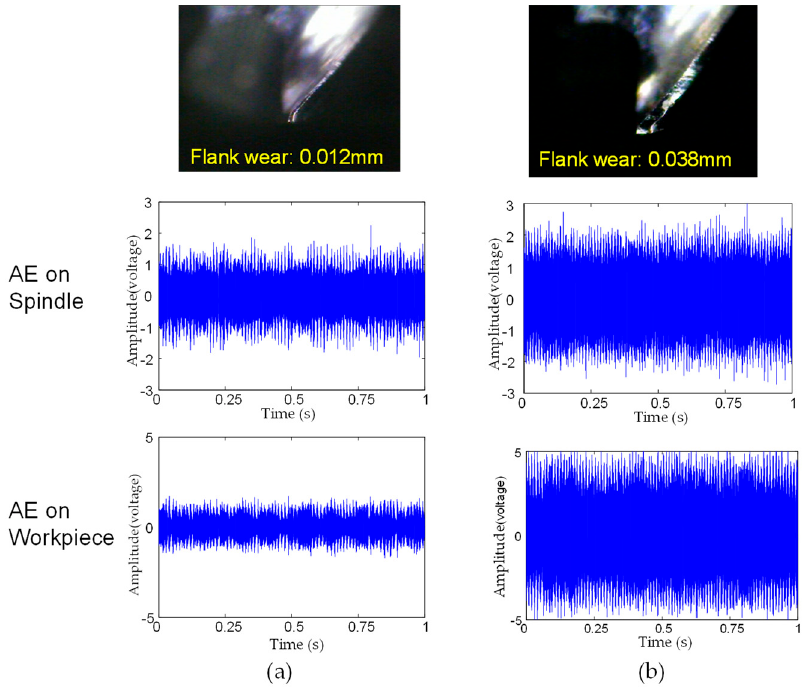
Figure 6. Tool wear level and corresponding time domain signal for tool condition: ( a ) sharp tool; ( b ) worn tool.